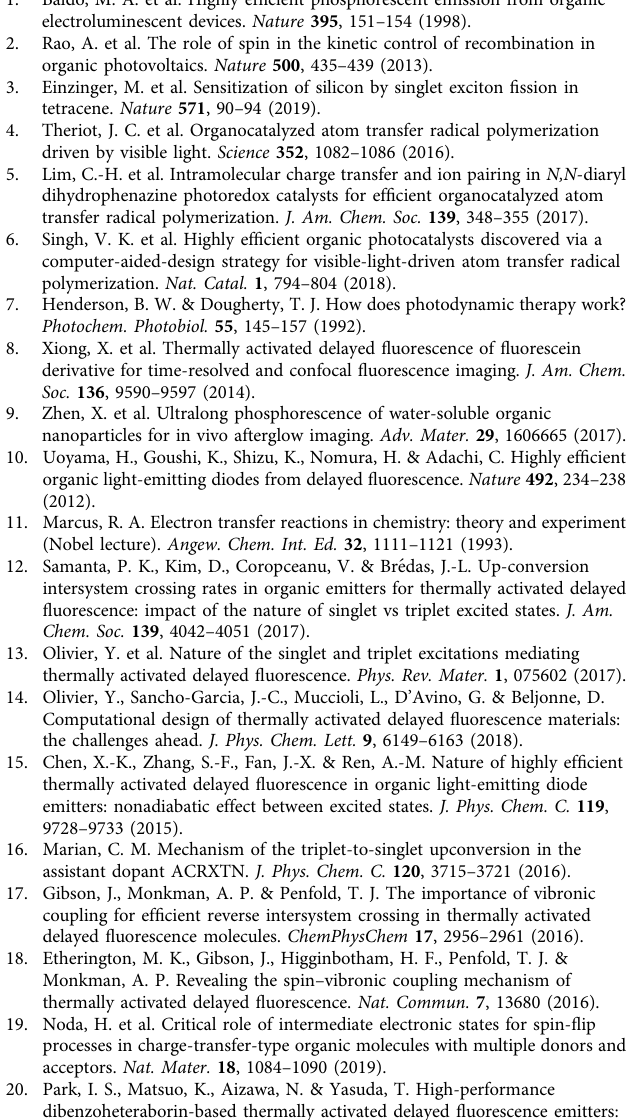
Fig. 5 Overview of theoretical k RISC . k RISC as a function of H SO and E A with a fi xed λ of 0.10 eV and T of 300 K. The H SO and E A values of the examined molecules are also